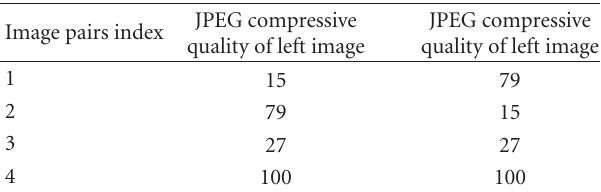
Table 2: Demands for the chosen four image pairs with di ff erent degrees of JPEG distortion.